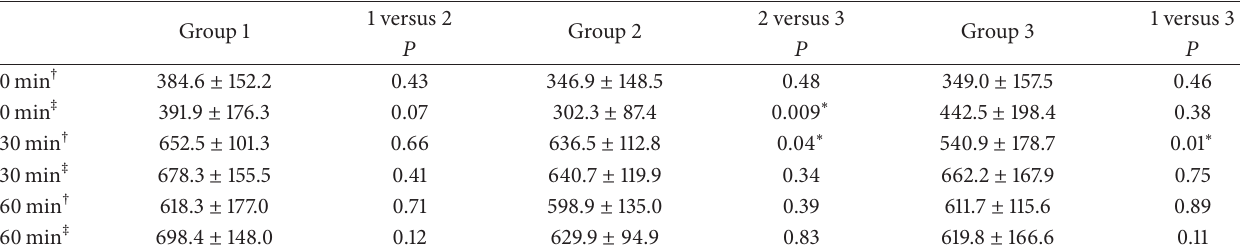
Table 3: Glucocorticoid functional assessment in the cases by groups (nmol/L). Group 1